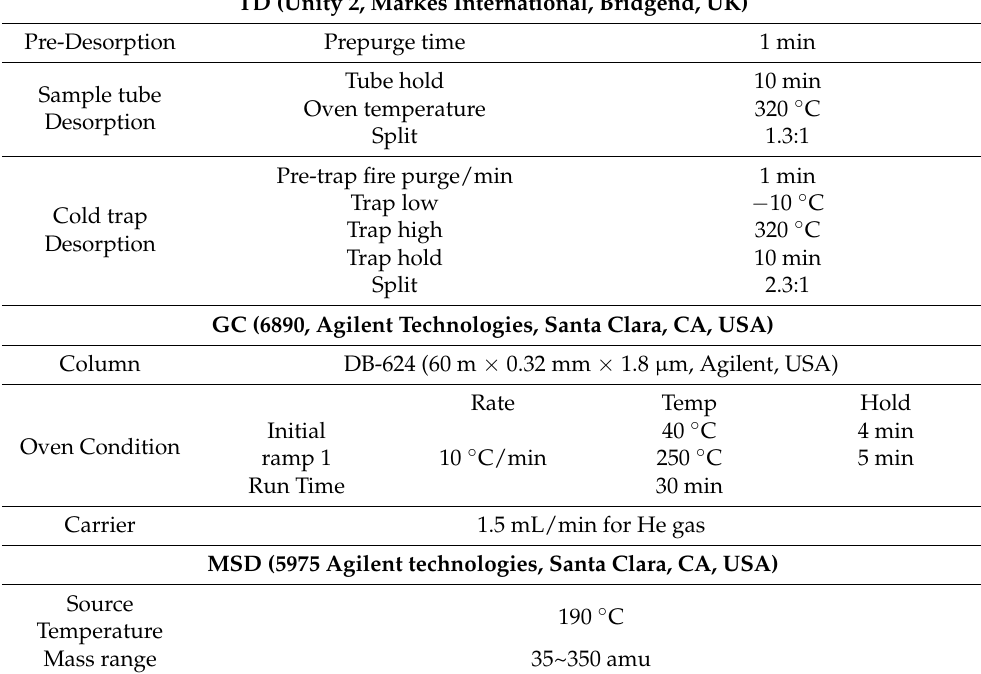
Table 1. The program parameters of